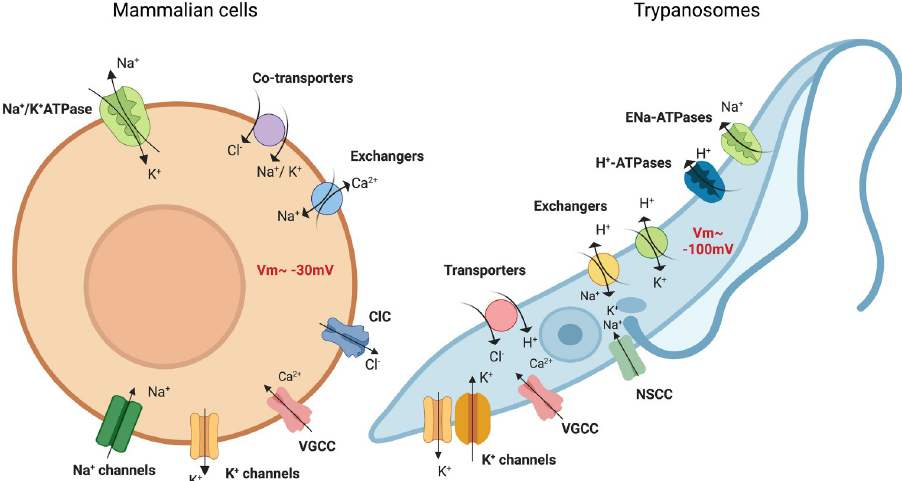
Fig 1. Channels and transporters involved in maintenance of the membrane potential in nonexcitable mammalian cells (A) and trypanosomes (B). In nonexcitable mammalian cells, the resting membrane potential (Vm) is maintained at values close to − 30 mV by the coordinated activity of ion channels and transporters. This membrane potential is driven by a high permeability to K + caused by the abundant expression of leak K + channels. Na + influx via channels, exchangers, and cotransporters is counterbalanced by the activity of the Na + /K + ATPase, main membrane pump found in vertebrates. Cl − , the most abundant intracellular anion, is regulated by electroneutral transporters such as the Cl − -Na + -K + cotransporter and by ClC channels. While Ca 2+ influx via VGCCs does not cause a significant change in the membrane potential directly, the cascade of signaling events associated with Ca 2+ entry affects expression and trafficking of the channels and transporters mentioned above. In trypanosomatids, and other protozoan parasites studied to date, membrane potential is driven by a proton motive force generated by the activity of H + ATPases, establishing a value of about − 100 mV for T . cruzi epimastigotes. Depending on the life stages analyzed, K + plays a secondary role on Vm maintenance and the hyperpolarization supports the influx of K + by channels and/or via exchangers. No Na + channels have been identified but permeation occurs through NSCCs and exchangers, while efflux is mediated by ENa ATPases. Figure created with BioRender.com . NSCC AU : AbbreviationlistshavebeencompiledforthoseusedinFigs 1 (cid:0) 3 : Pleaseverifythatallentriesarecorrect : , nonselective cation channel; VGCC, voltage- gated Ca 2+